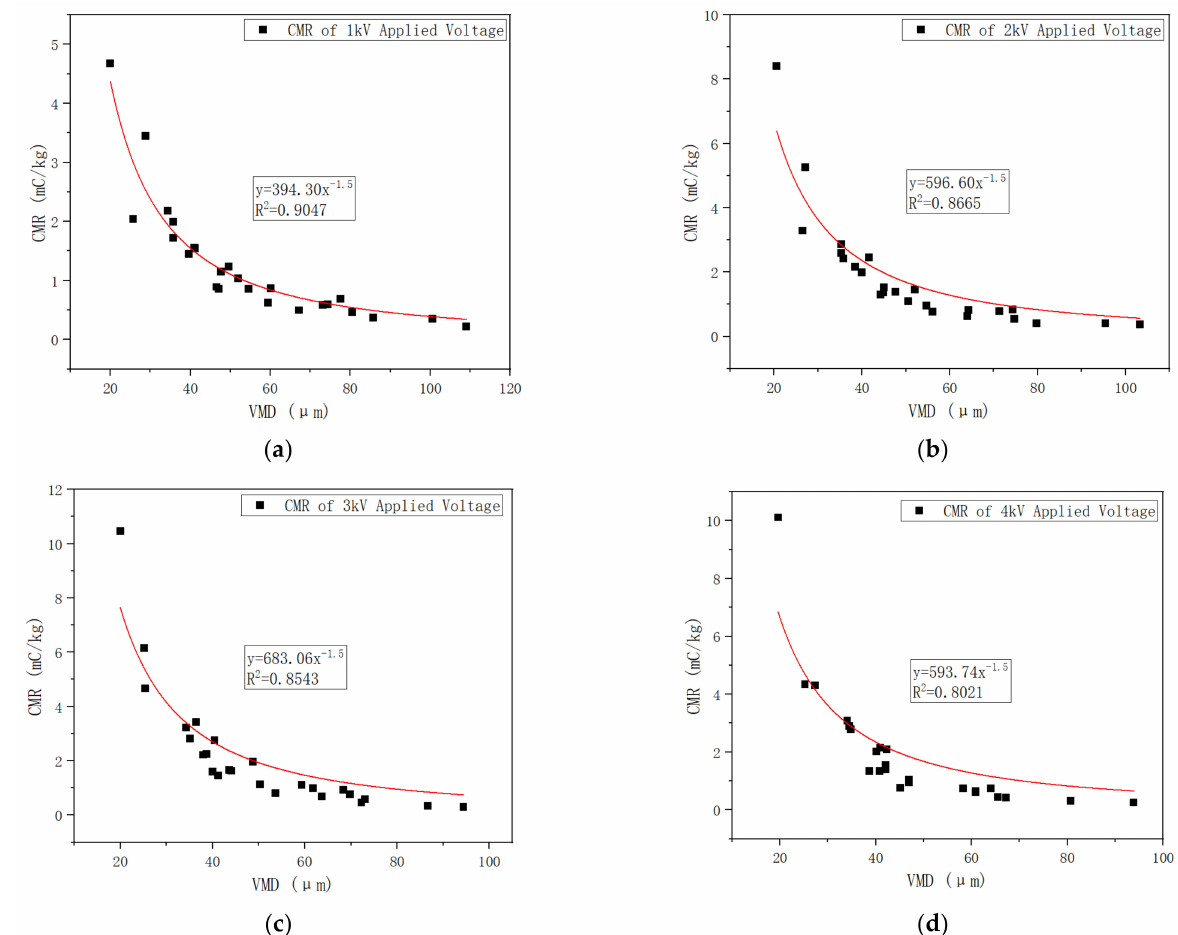
Figure 10. CMR variation with the VMD. ( a ) Applied Voltage of 1 kV, ( b ) Applied Voltage of 2 kV, ( c ) Applied Voltage of 3 kV, ( d ) Applied Voltage of 4